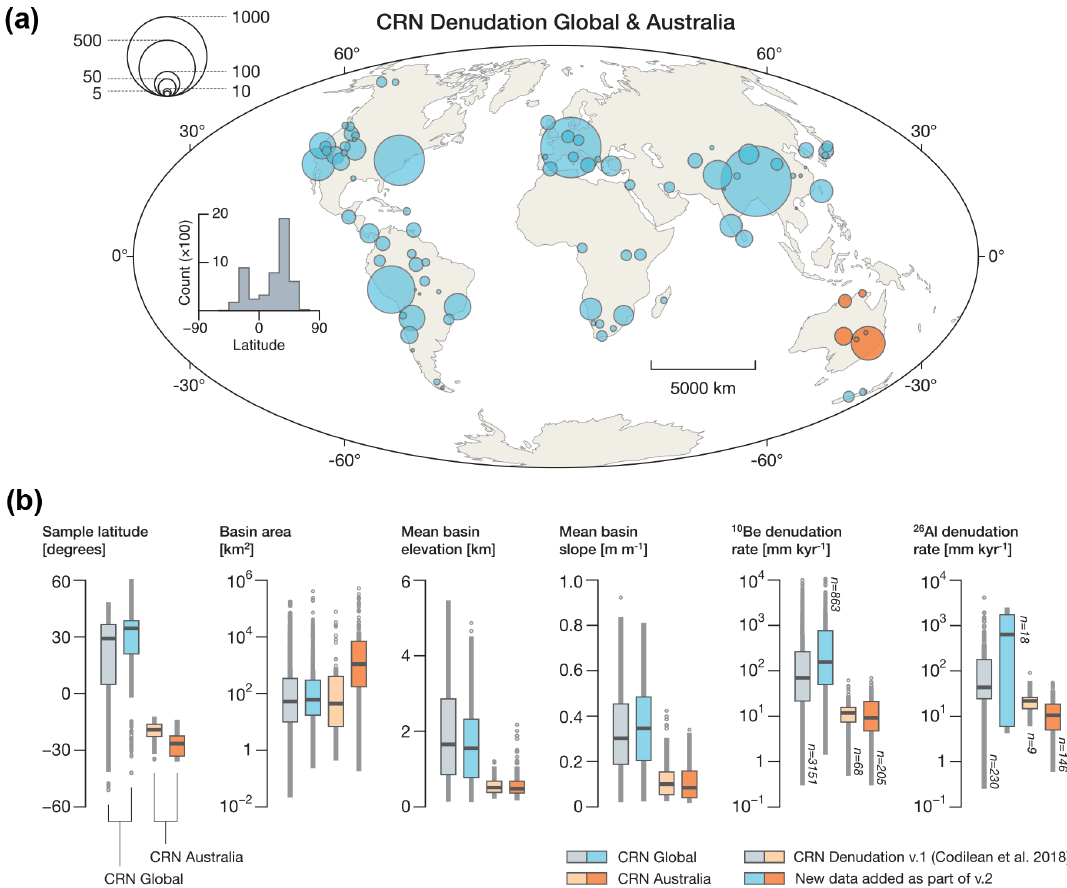
Figure 4. The CRN Denudation data collection. The size of circles corresponds to the number of observations in each 250km radius cluster. Blue circles denote CRN Global, and orange circles denote CRN Australia. Box plots are standard interquartile range (IQR) plots with outliers defined as data points > 1 . 5 × IQR. Box plots in blue hues represent the CRN Global sub-collection, box plots in orange hues represent the CRN Australia sub-collection, desaturated colours represent data available as part of OCTOPUS v.1 (Codilean et al., 2018), and saturated colours represent data added as part of OCTOPUS